Question: Write a descriptive caption for this figure.
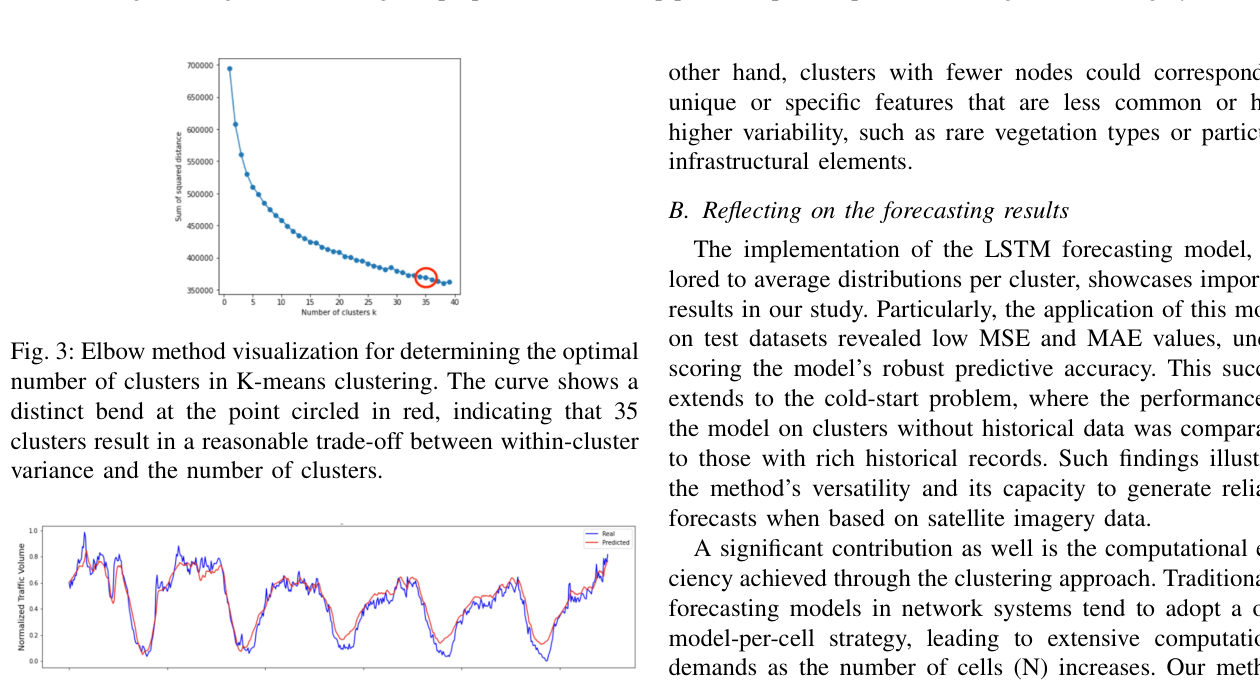
Answer: Comparison of real vs. predicted normalized traffic volume. The plot illustrates the close alignment between the actual data (blue) and the predictions (red) from the model, demonstrating how the average model can be used to forecast traffic for individual nodes per cluster.